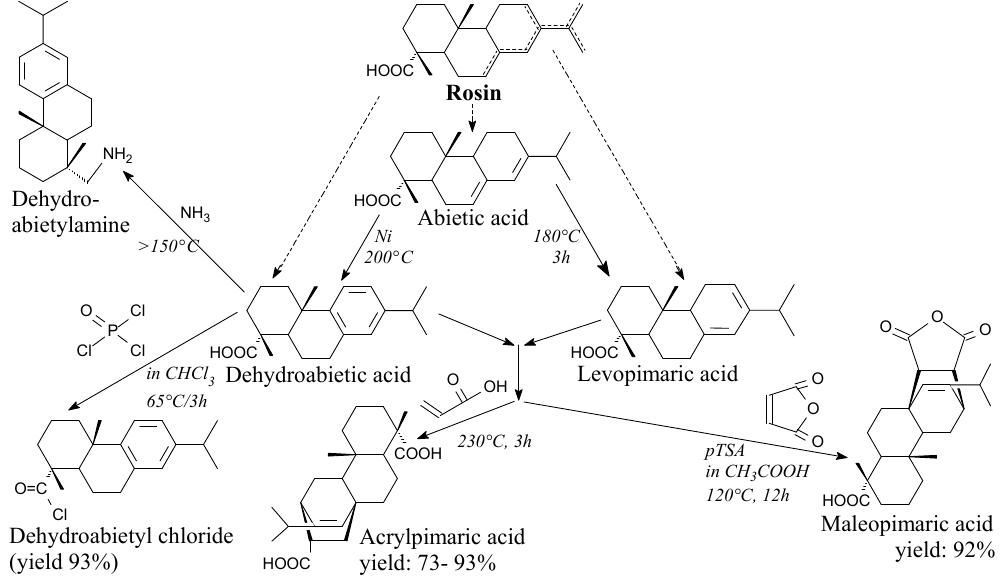
Figure 1. Structural formulas of the most common abietane-structured ( A – E ) and pimarane-structured ( F – H ) resin acids. Table 1. Composition of resin acids in gum rosin from different sources [23].